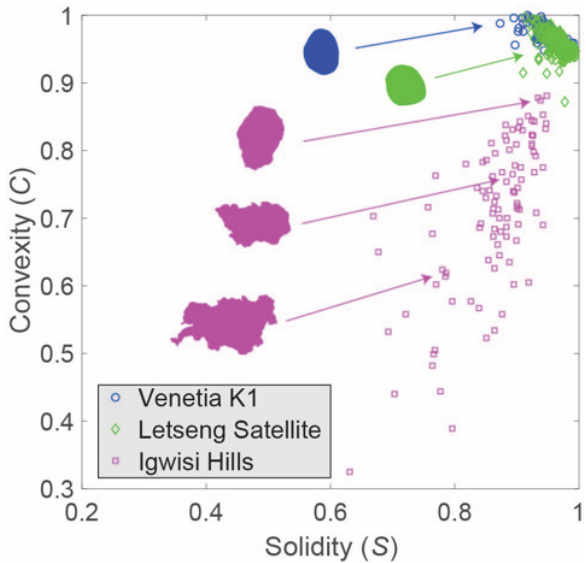
Figure 6: 2D Solidity and convexity shape factors for Igwisi Hills pyroclasts (Type 1 and Type 2 undi ff eren- tiated) alongside juvenile (pelletal) pyroclasts from the Letseng Satellite and Venetia K1 kimberlite [Gernon et al. 2012]. Particle outlines are not to